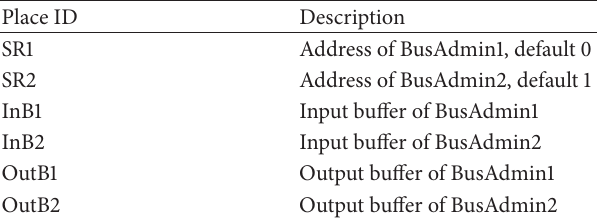
Figure 5: Top module.